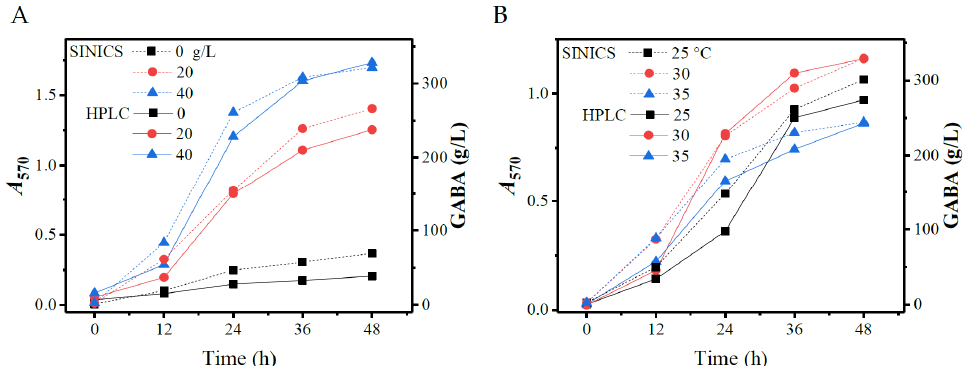
Figure 9. Optimization of GABA fermentation process performed by Levilactobacillus brevis CD0817 using HPLC and SINICS. ( A ) effects of yeast extract level on GABA formation; and ( B ) effects of temperature on GABA formation. HPLC: high performance liquid chromatography; SINICS: sensitivity intensified ninhydrin-based chromogenic system; GABA: gamma-aminobutyric acid; and A 570 : absorbance at 570 nm.